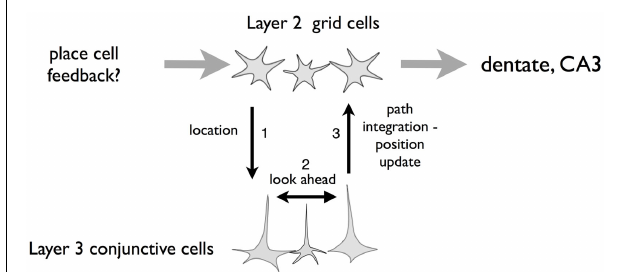
FIGURE 15 | Schematic of grid cells (layer 2 EC) and conjunctive cells (layer 3 EC). We hypothesize vertical integration and interaction between overlying layer 2 grid cells and deeper layer 3 conjunctive cells. Additionally, the conjunctive cells are interconnected to provide the “linear look-ahead” described in the paper. Each of the arrows can operate independently.The grid cell projection to conjunctive cells “sets up” the conjunctive cells to be in register with grid cells and sensory cues from the environment. If this influence is reduced and inter conjunctive cell interaction turned on (along with head-direction input) the conjunctive cell layer can process linear look-ahead, to predict locations ahead of the animal’s nose. Finally, the conjunctive cell layer projects to the grid cell layer, permitting the grid cells to reflect the look-ahead mechanism.We see three functions of linear look-ahead. First, the mechanism can do long-distance look-ahead while the animal is stationary to predict distance locations. Second, the mechanism can do short-distance look-ahead, providing continual update while the rat is in motion. Finally, the mechanism can add to the cohesion of both conjunctive cells and grid cells, making a rigid network even more